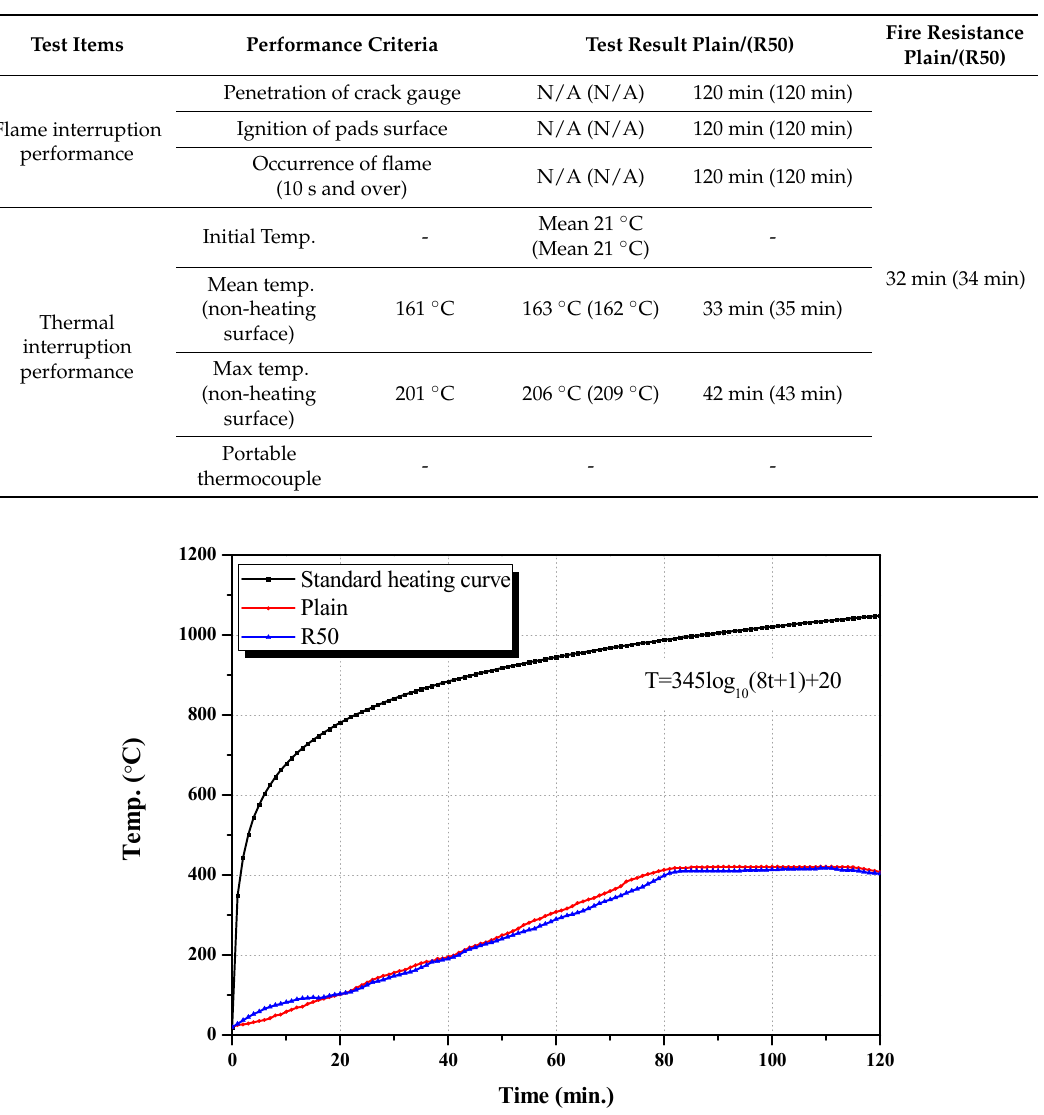
Table 7. Fire-resistance tests during 120min.